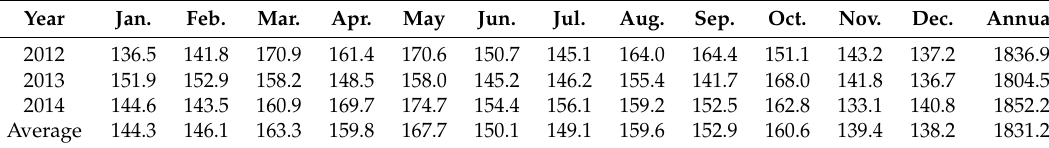
Table 5. The solar radiation from 2012 to 2014 in Subang city (kWhm − 2 ).